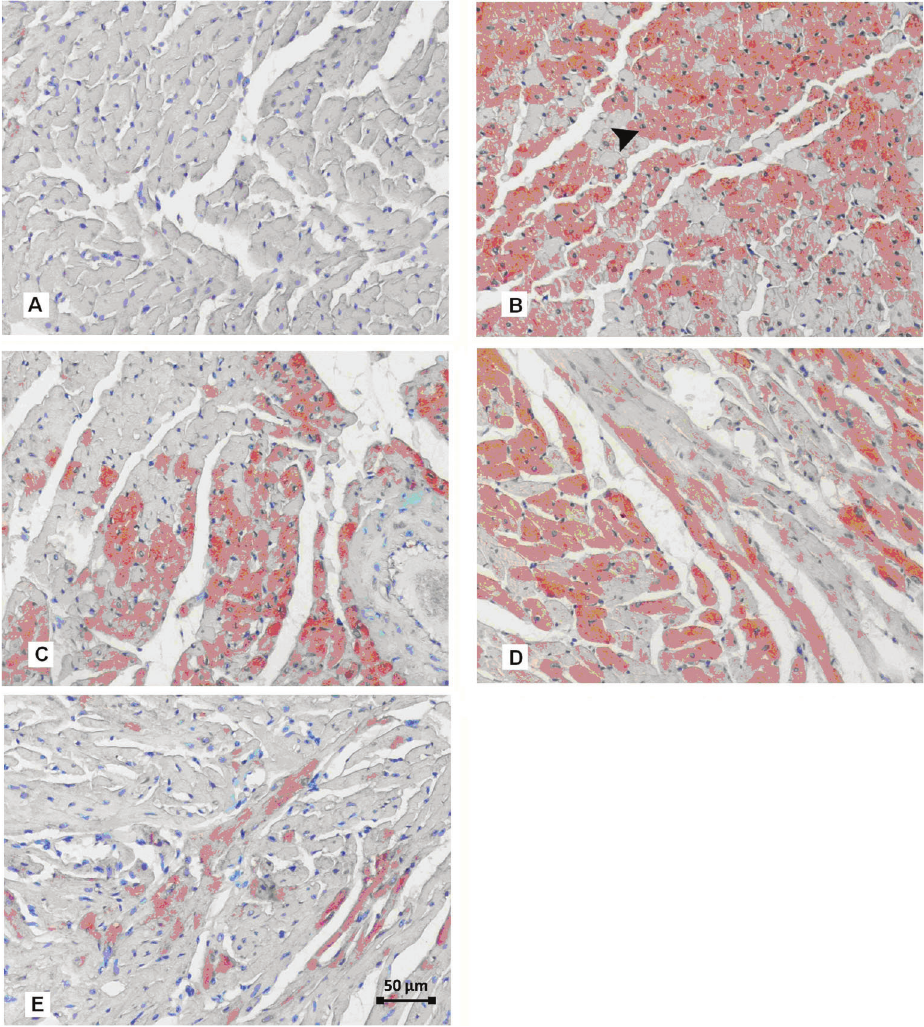
Figure 2. Immunohistochemical expression of inducible nitric oxide synthase (iNOS) in the control and treatment groups of heart muscle. A , There is no immunopositive reaction of iNOS in muscle fibers of S group. B , Strongly positive iNOS immunoreactivity of heart muscle (arrowhead) in Cont group. C , Moderate immunopositive reaction in Cont++QC group. D , Intermediate iNOS immunoreactivity of heart muscle in Cont++MP group. E , Weak immunopositive reaction of iNOS in Cont++MP++QC group. S: Sham; Cont: cardiac contusion; Cont++MP: Cont group treated with methylprednisolone; Cont++QC: Cont group treated with quercetin; Cont++MP++QC: Cont group treated with methylprednisolone and quercetin. Immunoperoxidase technique, Harris hematoxylin counter staining, 3-amino-9-ethylcarbazole (AEC) as a chromogen, 20 6